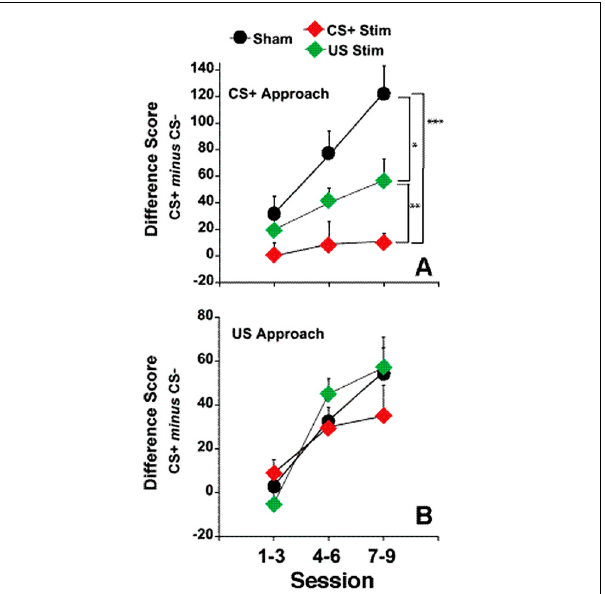
FIGURE 3 | Partial contrast conditioning schedule: (A,B) represent the effects of fr lesion on conditioned approach to each CS (A) and to the US (B) during the presentation of a 100% CS + and 33% CS − presentation. (C,D) represents the difference score (CS + minus CS 33 ) derived from values represented in (A,B) . n = 6, 7 for the Sham and Lesion groups, respectively. Error bars represent S.E.M.